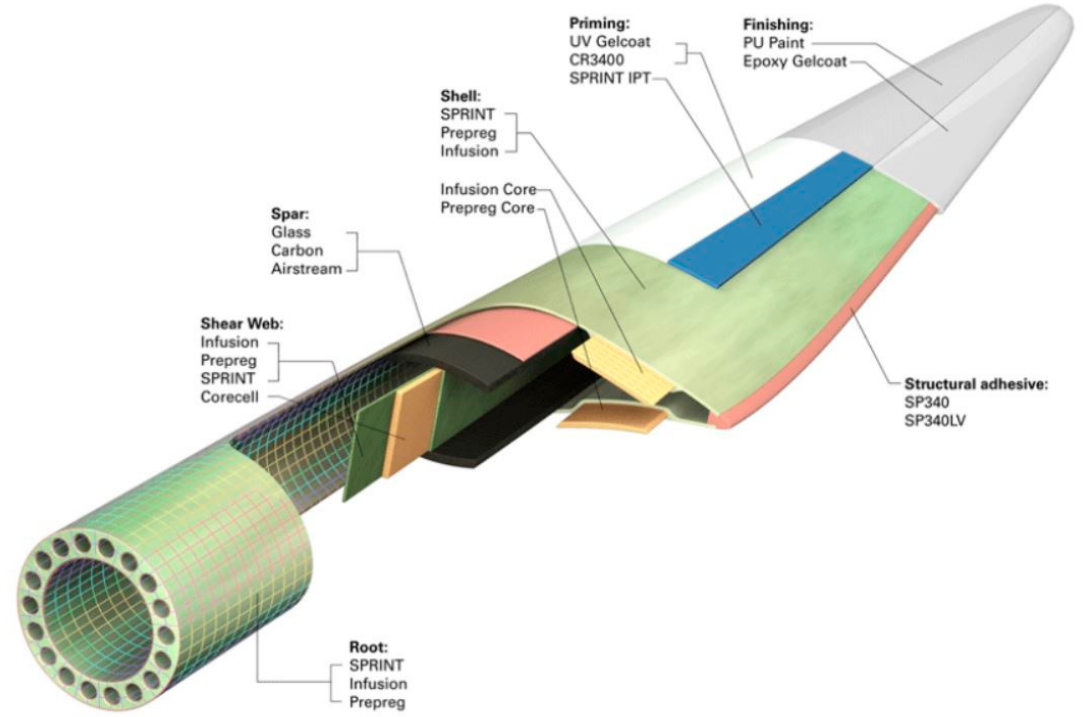
Figure 1. Cross-section of wind power plant blade, including the most important materials and components [10].